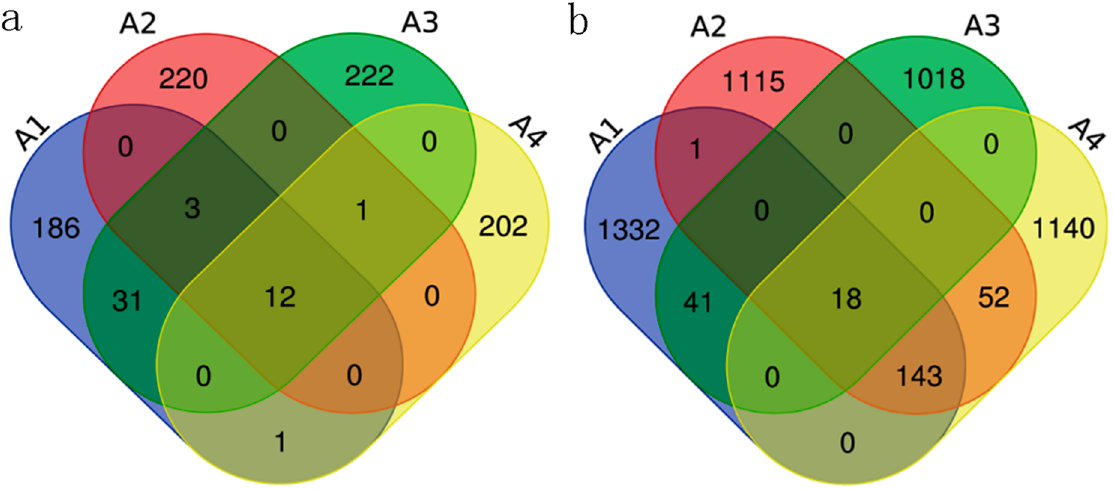
Figure 5. Sample Venn diagram. Note: ( a ) is the fungal Venn Diagram, ( b ) is the bacterial Venn